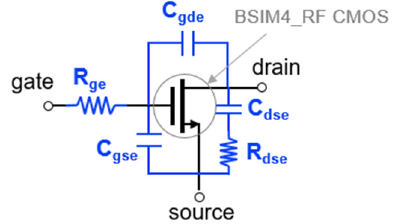
Figure 5. Macro model equivalent circuit of RF CMOS used in this work.